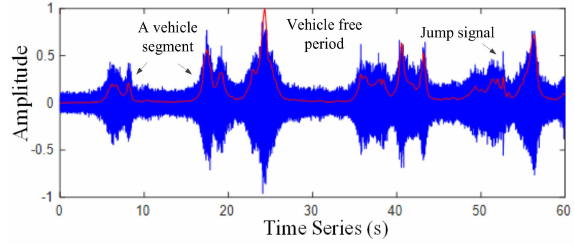
Figure 4. Waveform of traffic noise signal and its STE.